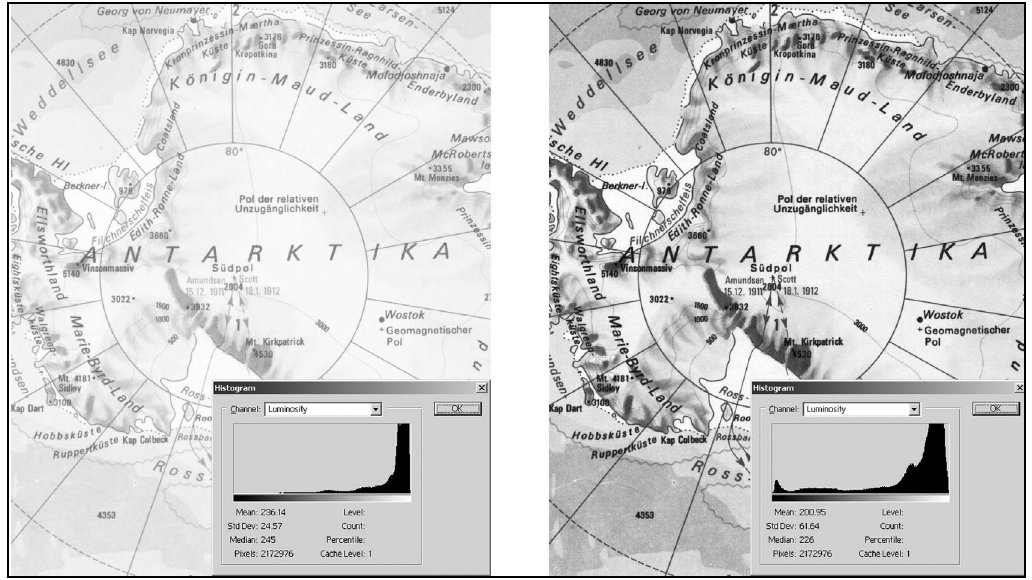
6 pav. Žem ė lapio histograma: kair ė je – po skenavimo išbluk ę s vaizdas, dešin ė je – vaizdas atlikus spalv ų balansavim ą Fig 6. Hystogram of a map view: light view after scanning (left) and improved view after correction of colours (right)